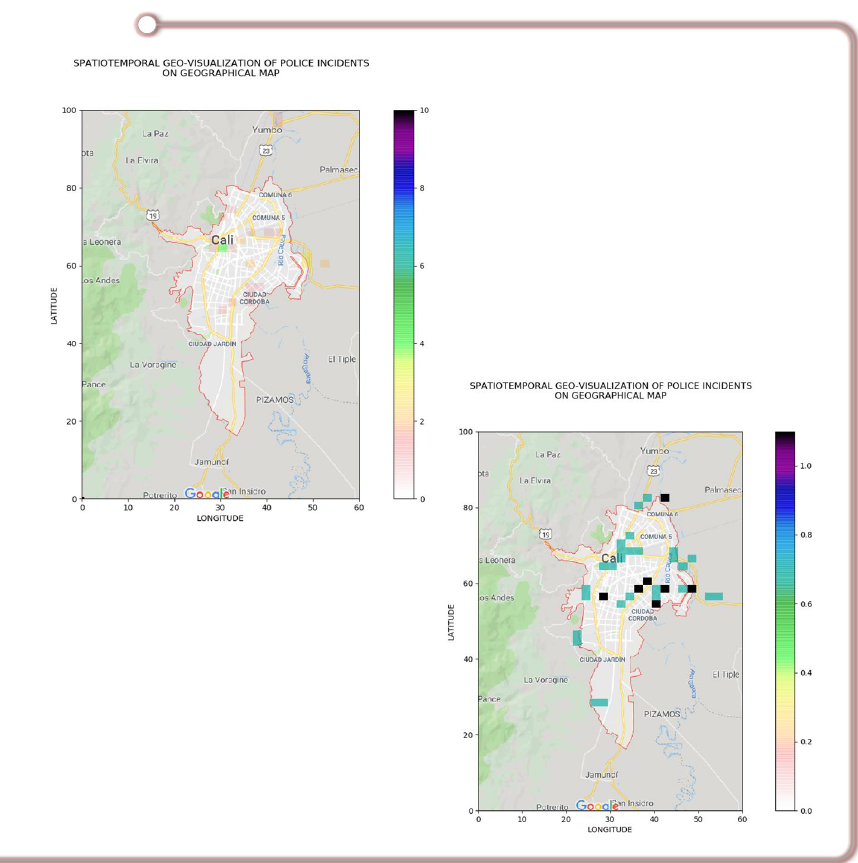
Figure 6. Graphics of spatiotemporal dynamic geo-visualization of criminal data on geographical map (capture). In order: Spatiotemporal dynamic geo-visualization of criminal data on geographical map in an initial frame; and spatiotemporal dynamic geo-visualization of criminal data on geographical map in another frame. In this case, there are 30-min temporary sliding window and ∆ t = 20 min.